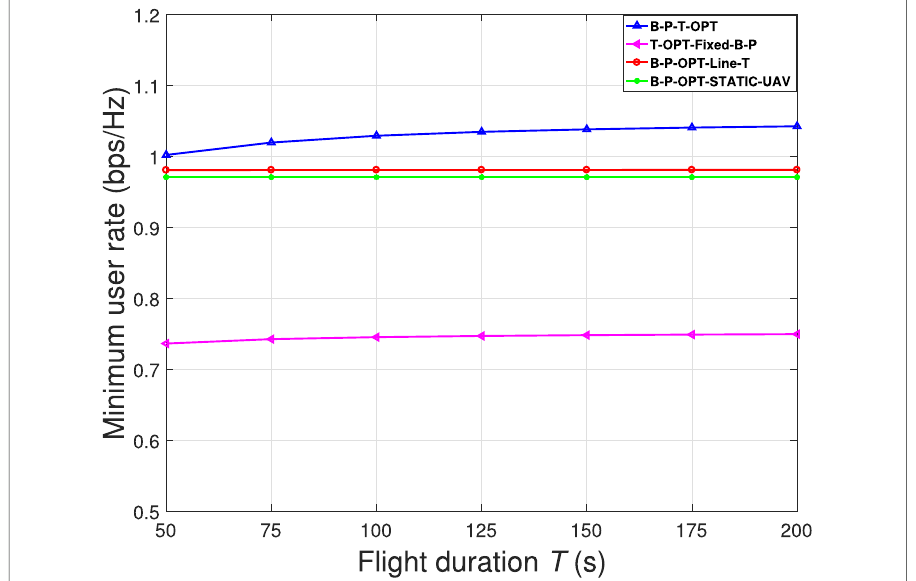
Fig. 7 Minimum user rates versus UAV-BS’s flight duration